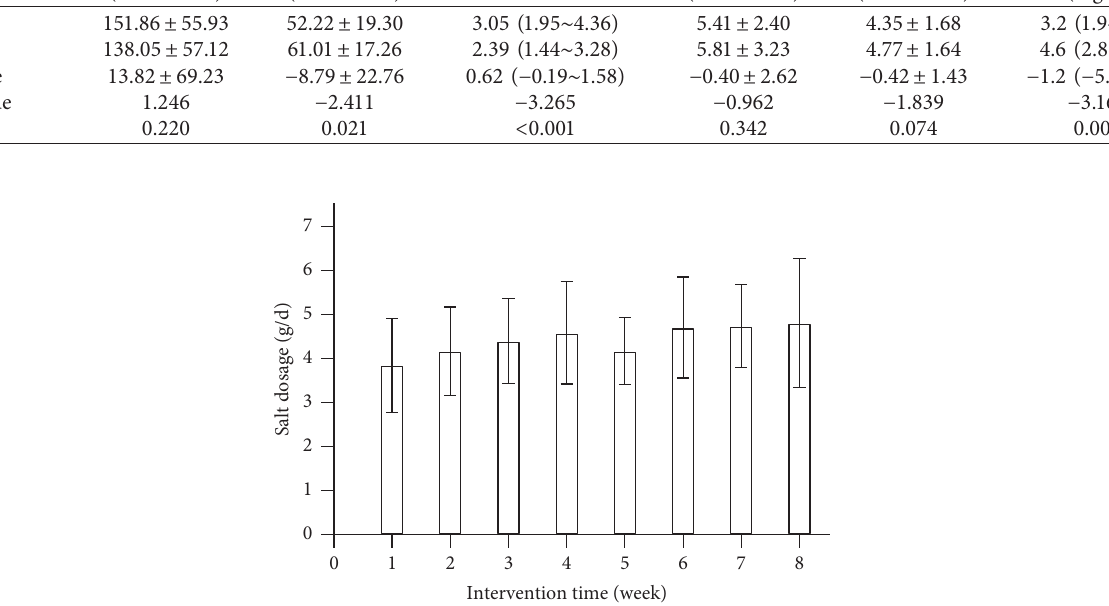
Figure 1: Per capita daily 18% substitute salt dosage ( n � 39). Table 3: Changes in blood pressure from baseline during intervention, mean (95% CI) ∗